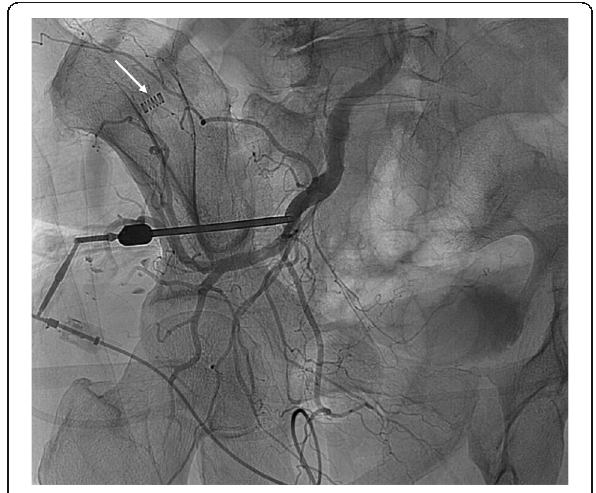
Fig. 1 Direct needle angiogram via the bone marrow biopsy needle showed opacification of the left internal iliac artery. A springe-like radio-opacity (white arrow) which belonged to an extracorporeal tubing was noted